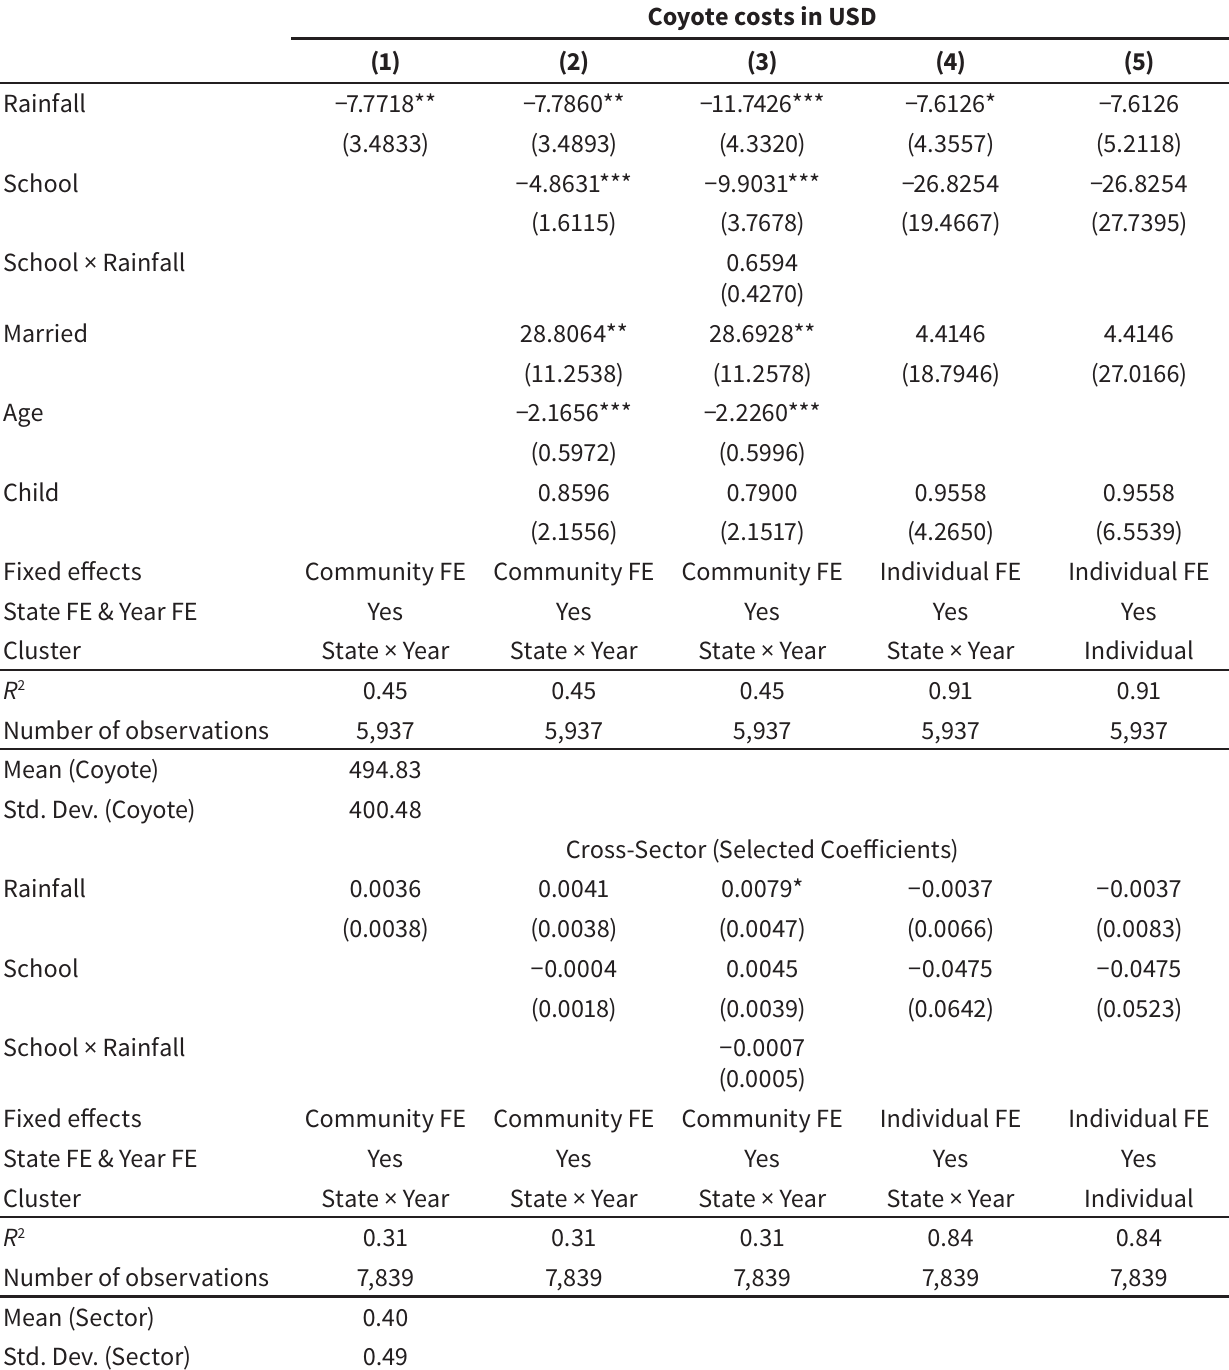
Male migrants’ coyote costs and sector choices change with